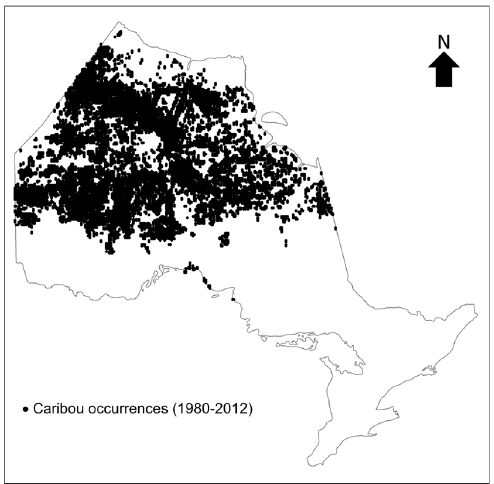
Figure 2. The presence (black) and absence (white) of woodland caribou throughout the province of Ontar- io during winter (Jan – Mar) between 1980 and